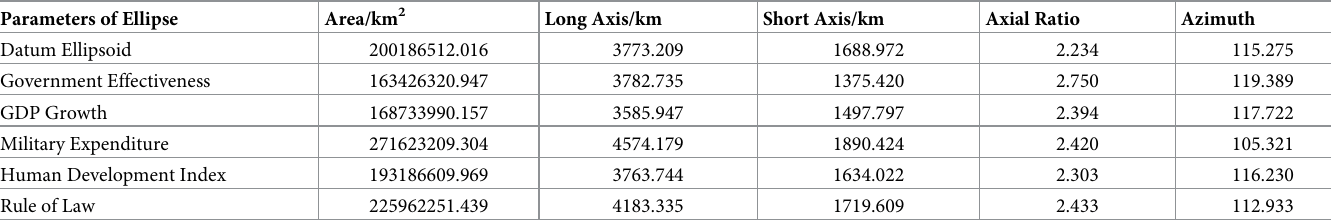
Table 6. Spatial layout parameters of geopolitical environmental information in the